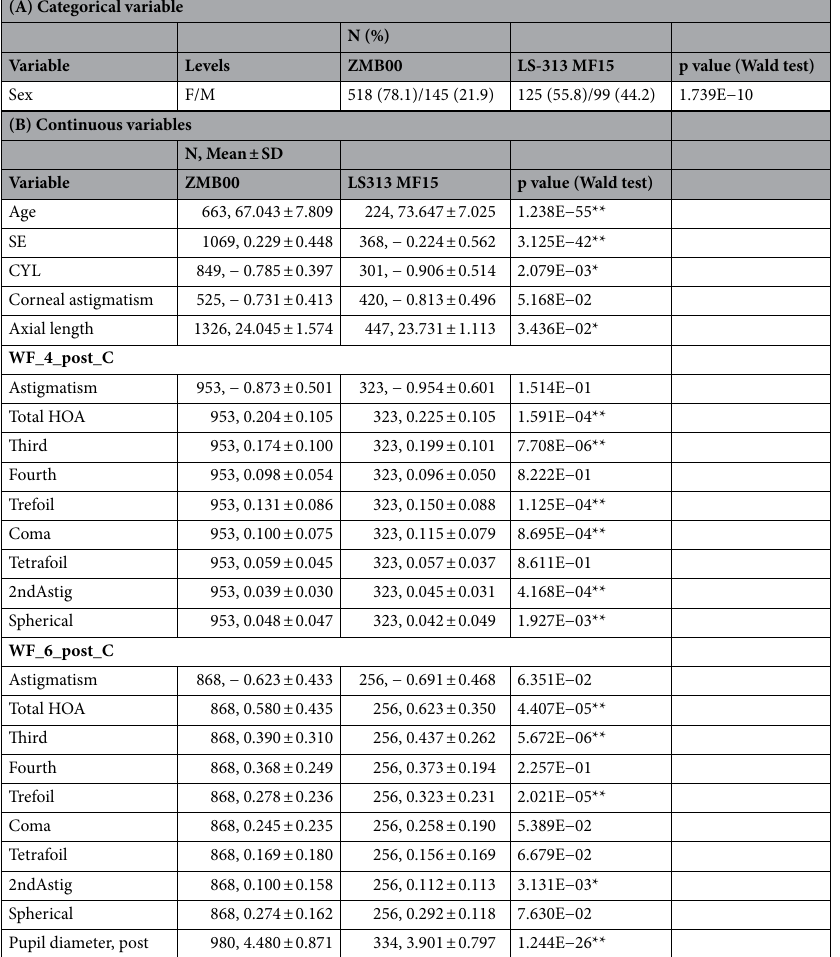
Table 1. Parameters in the diffractive bifocal (TECNIS ZMB00) and rotationally asymmetric refractive (Lentis Comfort LS-313 MF15) groups used to adjust the linear regression model: age, sex, axial length (at the time of surgery), subjective refraction spherical equivalent (SE), subjective refraction cylinder (CYL), corneal astigmatism (keratometric cylinder), corneal higher-order aberrations (astigmatism, total higher-order aberration (HOA), third, fourth, trefoil, coma, tetrafoil, second-order astigmatism (2ndAstig), spherical (scaled to a pupil size of 4 mm/6 mm), and pupil diameter (at 10 weeks after surgery). For categorical data, counts and frequencies are shown. Fisher’s exact test (two-sided) was used to compare categorical data for the diffractive bifocal and rotationally asymmetric refractive IOLs. For numerical data, the mean and standard deviation are shown, and the two-sided Mann–Whitney U test was used to compare numerical data for the diffractive bifocal and rotationally asymmetric refractive IOLs. SE, subjective refraction spherical equivalent; CYL, subjective refraction cylinder; WF_4_post_C_, wavefront_4_post_corneal; HOA, higher-order aberration. *p < 0.05, **p < 0.002 (=